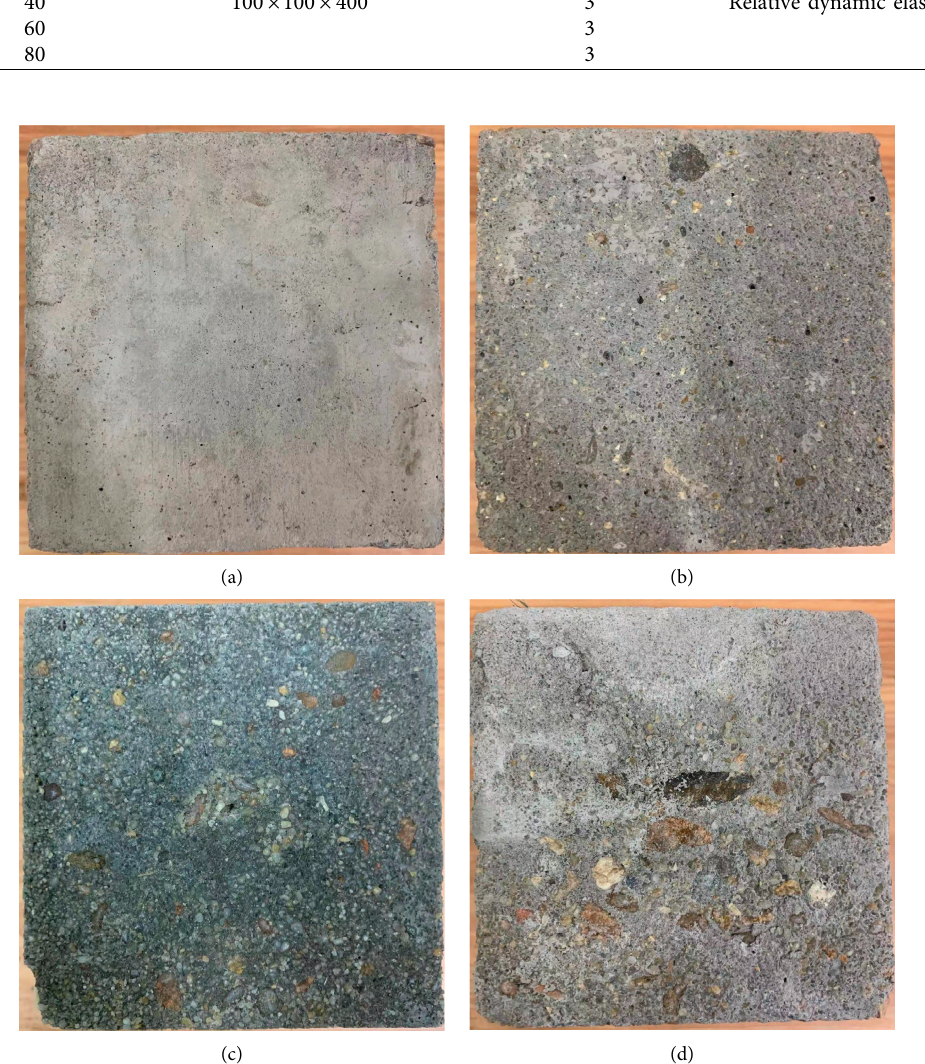
Figure 2: Damage pattern of concrete surface after freeze-thaw (number of freeze-thaw cycles: (a) 0 times; (b) 40 times; (c) 80 times; (d) 120